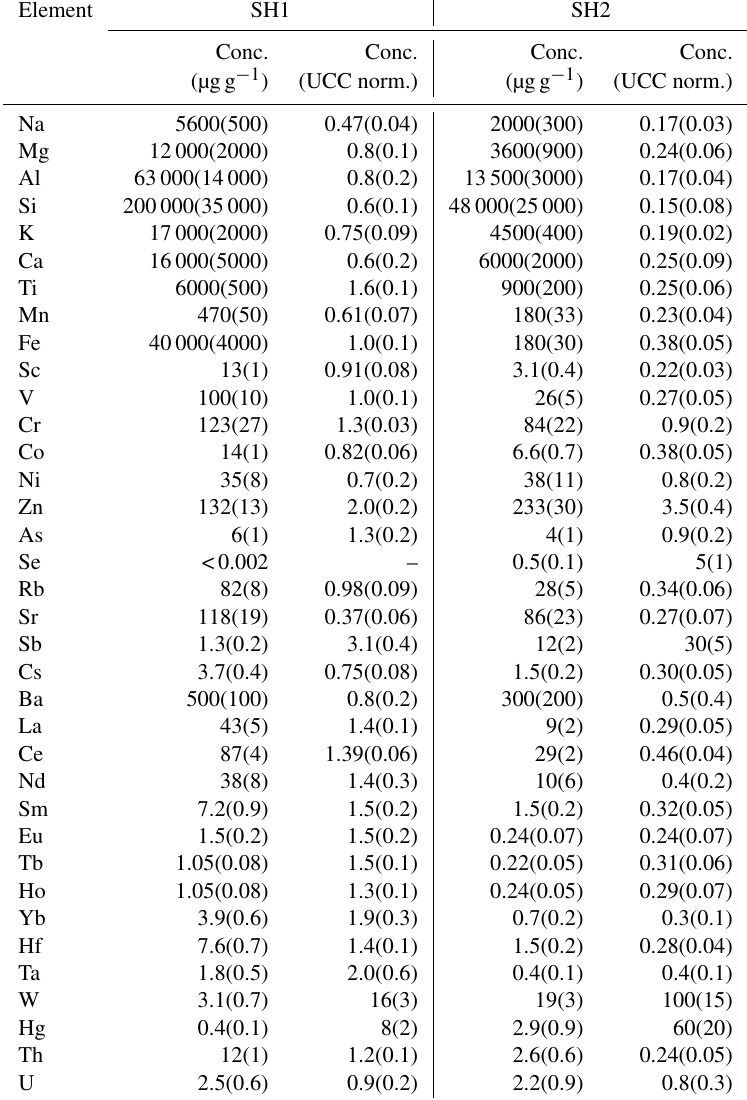
Table 1. The elemental composition of SH1 (snow sample containing mineral dust) and SH2 (clean snow sample). Data are expressed (in terms of µgg − 1 ) and are referred to the mass of the extracted material, not to the considered snow volume. Values in brackets are measurement uncertainties. Normalized concentrations were calculated considering the upper continental crust as a reference (Rudnick and Gao,